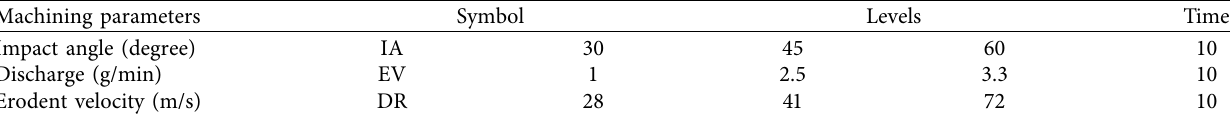
Table 3: Control factors and levels for air jet erosion test.